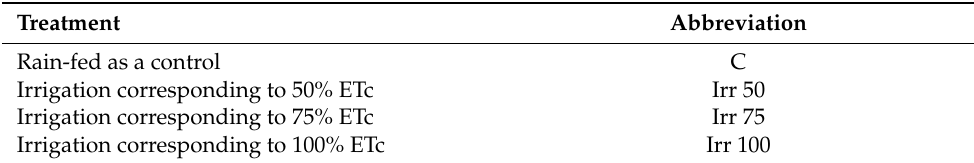
Figure 1. Rainfall, air temperature and evapotranspiration during the growing seasons of ( a ) 2015, ( b ) 2016 and ( c ) 2017. Table 1. Experimental treatments and abbreviations used in the